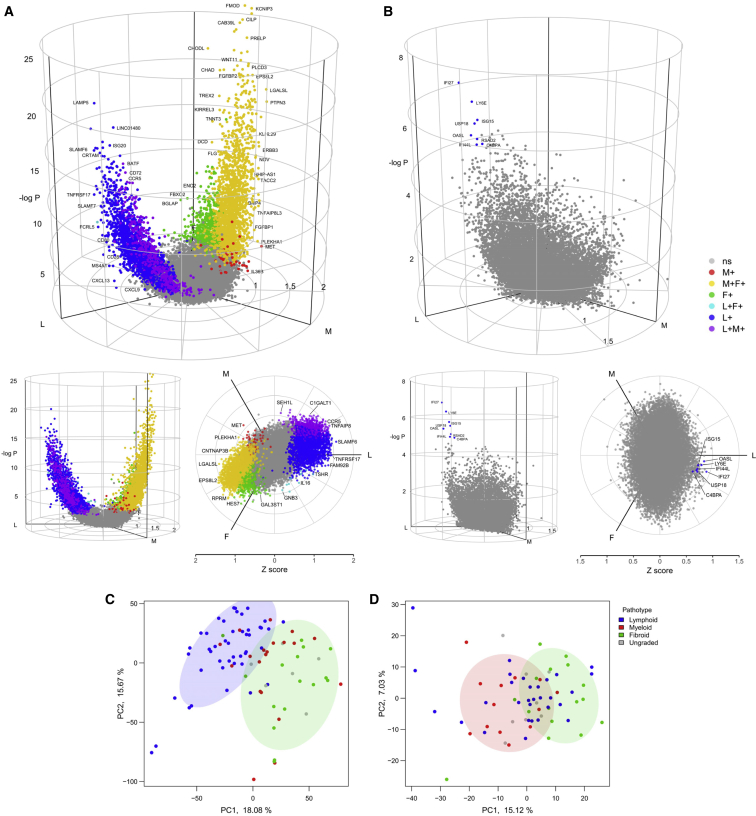
Synovium and Blood RNA-Seq Comparison Reveals Differential Axes of Gene Expression(A and B) 3D cylindrical volcano plots of differentially expressed genes comparing RNA sequencing of (A) synovial tissue and (B) whole blood. Vectors for pathotype mean Z score per gene were projected onto a polar coordinate space analogous to RGB (red-green-blue) color space mapping to HSV (hue-saturation-value) as described in the STAR Methods. Lympho-myeloid, diffuse-myeloid, and pauci-immune fibroid vectors are mapped to 3 axes lympho-myeloid (L), diffuse-myeloid (M), and pauci-immune fibroid (F) using polar coordinates in the horizontal plane. The z axis shows –log10 p value for likelihood ratio test. Genes with adjusted p value for likelihood ratio test < 0.05 (z axis) were considered significant (non-significant genes colored gray). Colors demonstrate pairwise comparisons (FDR < 0.05) between the 3 histological pathotypes: primary colors denote upregulation in one group only for lympho-myeloid (blue), diffuse-myeloid (red), and pauci-immune fibroid (green) compared to reference group with minimum gene expression; composite colors show genes significantly upregulated in two groups (myeloid+lymphoid, purple; fibroid+myeloid, yellow; lymphoid+fibroid, cyan). Lateral view and 2D polar plots are shown below.(C and D) Principal-component analysis of whole transcriptome RNA-seq data from untreated rheumatoid arthritis (C) synovium and (D) whole blood, showing separation of lympho-myeloid (blue) and pauci-immune fibroid (green) histological pathotypes on principal component 1 (PC1) for synovial RNA-seq, with separation of diffuse-myeloid (red) and pauci-immune fibroid samples on PC1 in whole blood.